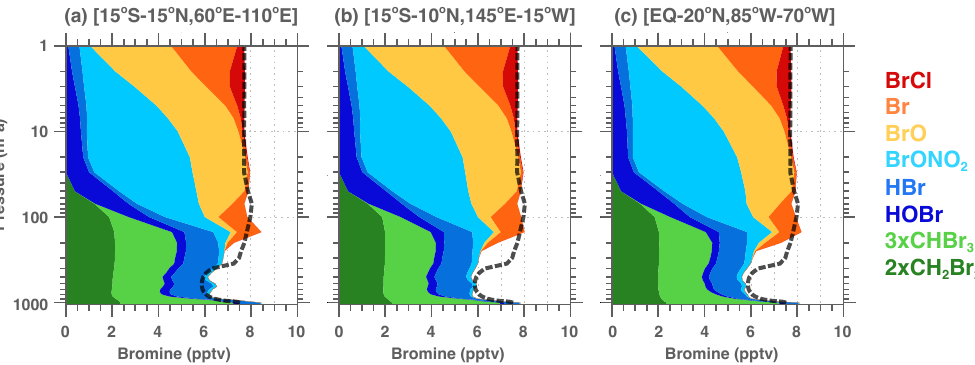
Figure 6. The contribution of organic bromine (CH 2 Br 2 × 2, CHBr 3 × 3) and inorganic bromine (Br VSLS y ) from CHBr 3 and CH 2 Br 2 degra- dation to atmospheric bromine in three active TST regions: (a) the tropical Indian Ocean (left), (b) the tropical western Pacific warm pool (middle), and (c) the Pacific coast of Mexico (right). The soluble product gases (HBr, HOBr, BrONO 2 ) and insoluble product gases (Br, BrO, BrCl) are shown in blue shades and red and yellow shades, respectively. The global mean sum of organic and inorganic bromine from VSLSs is also shown (thick black dashed line). The model results are 10-year annual averages from 2001 to